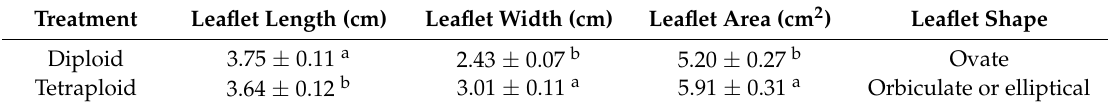
Table 4. Effect of polyploidy on morphology of leaflets in Salvia miltiorrhiza.